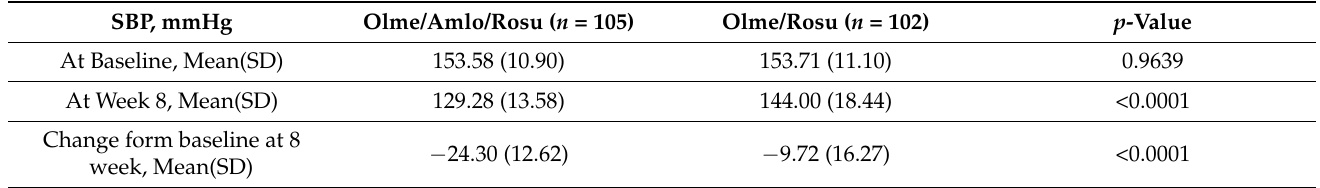
Table 2. Change of sitSBP at 8 weeks comparing olme/amlo/rosu and olme/rosu group.